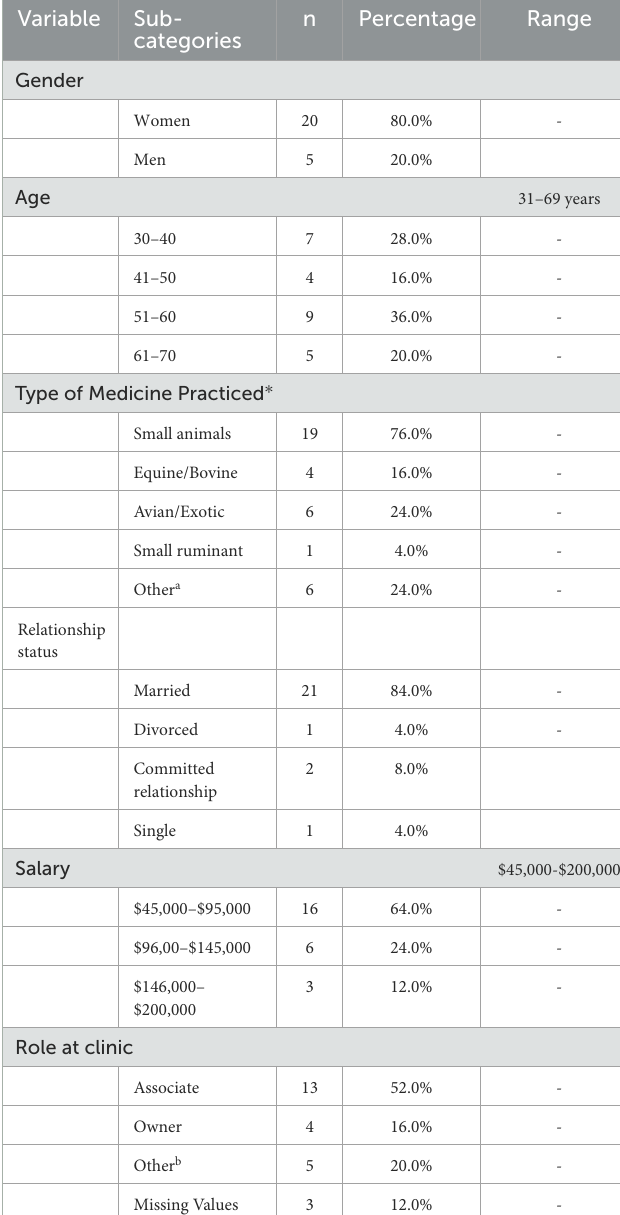
TABLE 1 The demographic factors of veterinarians ( n = 25) who participated in one-on-one